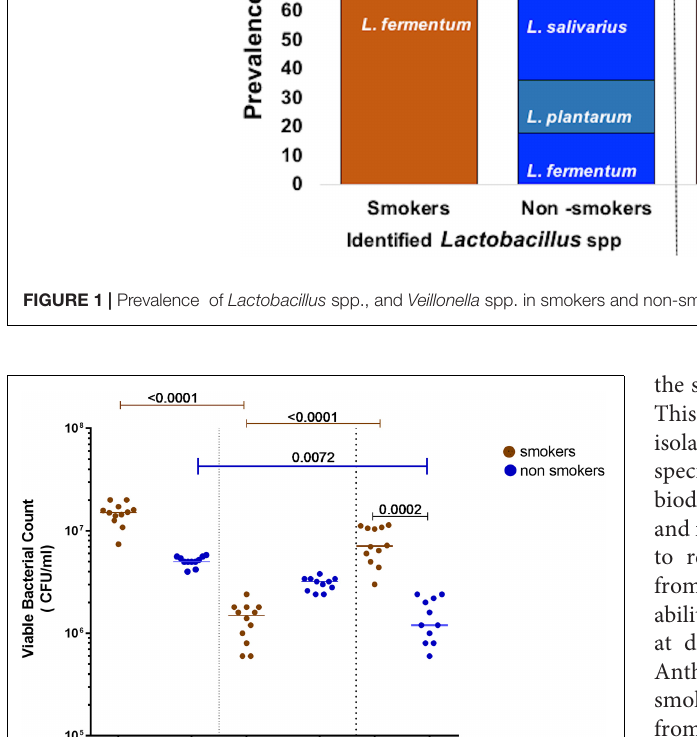
counts was higher than Lactobacillus spp. and Veillonella